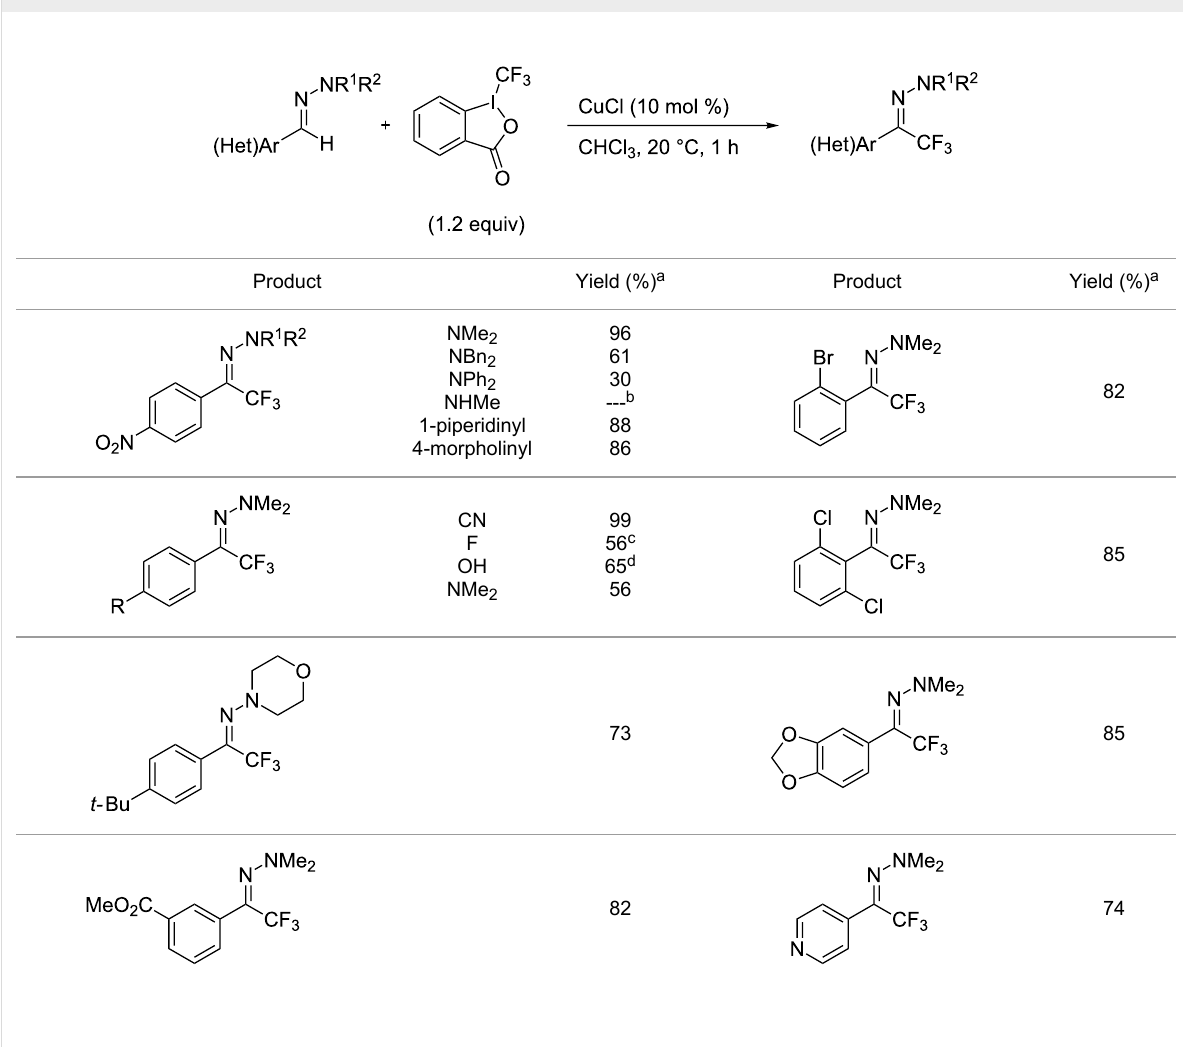
Table 18: Baudoin’s Cu-catalyzed trifluoromethylation of N , N -disubstituted (het)arylhydrazones